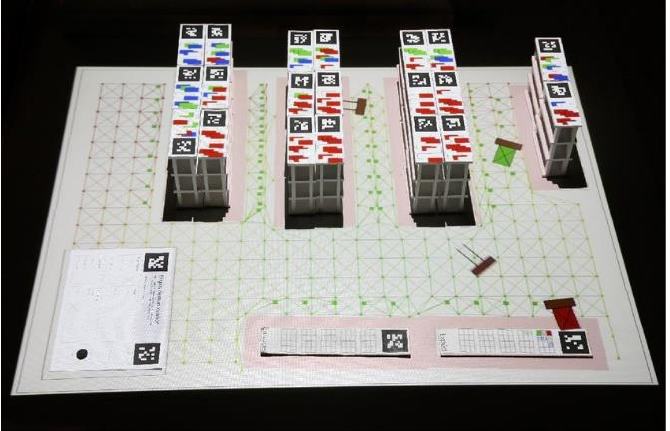
Figure 2. Tinker system for simulation of the warehouse